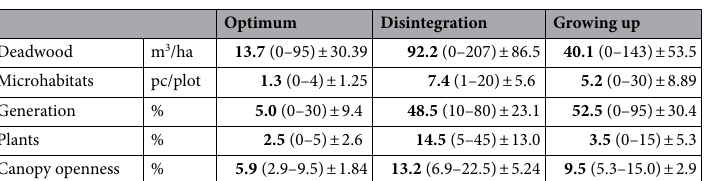
Table 1. Table showing the variables surveyed by stage. The mean value is marked in bold. In brackets is range (minimun-maximum) and followed by the Std. Dev.